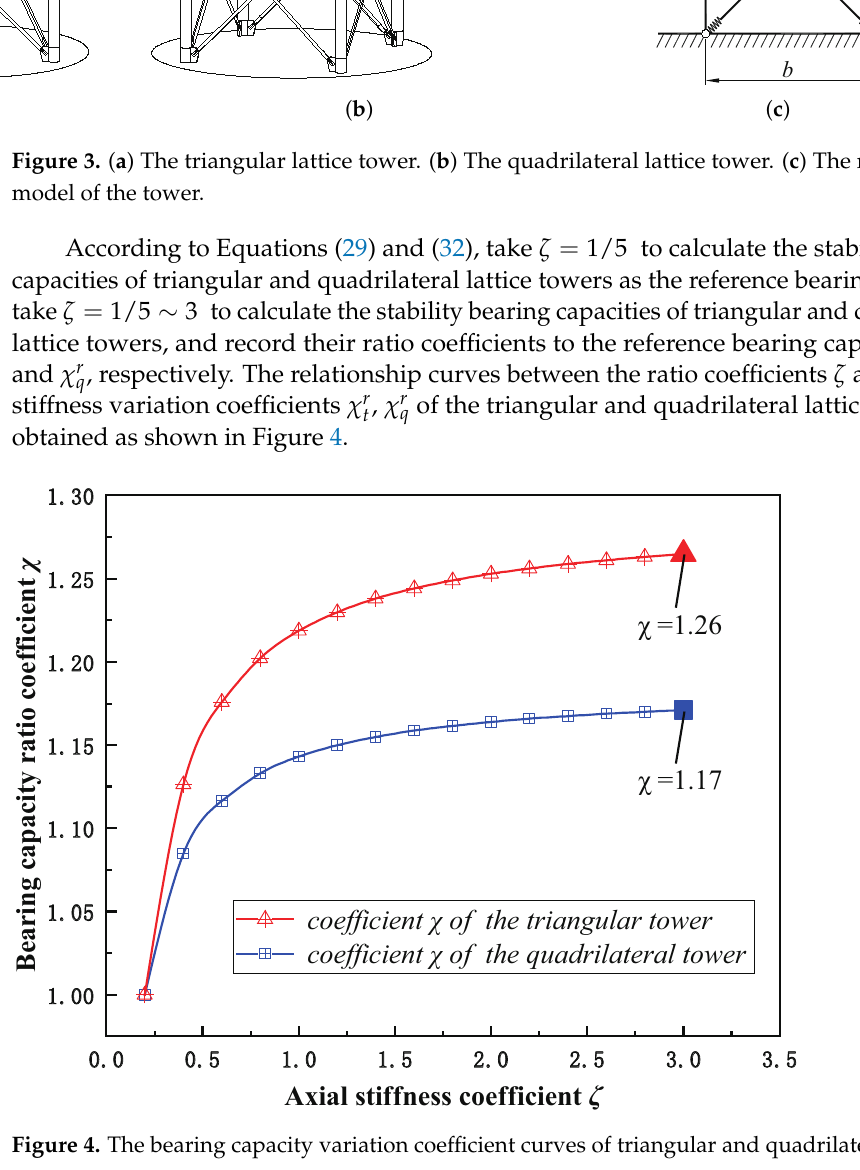
(cid:3) coefficient χ of the triangular tower (cid:3) coefficient χ of the quadrilateral tower